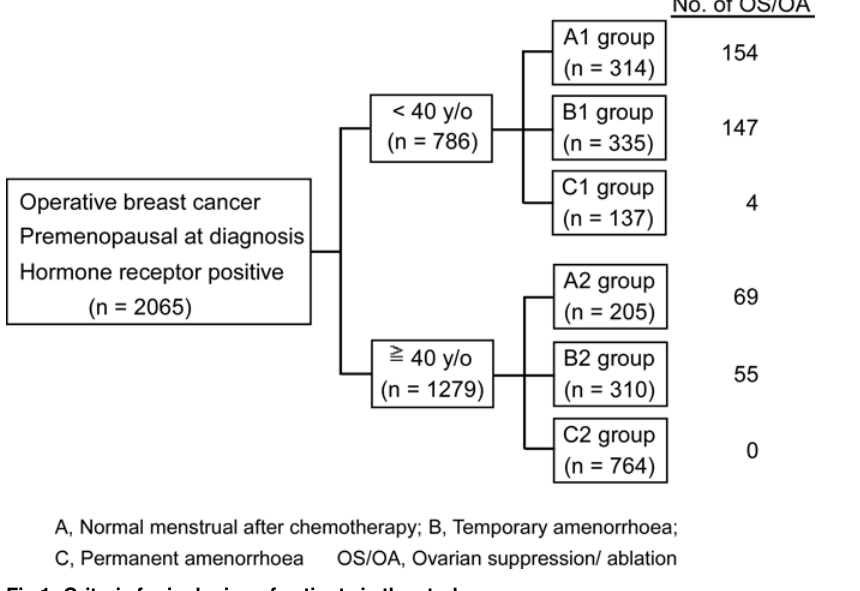
Fig 1. Criteria for inclusion of patients in the